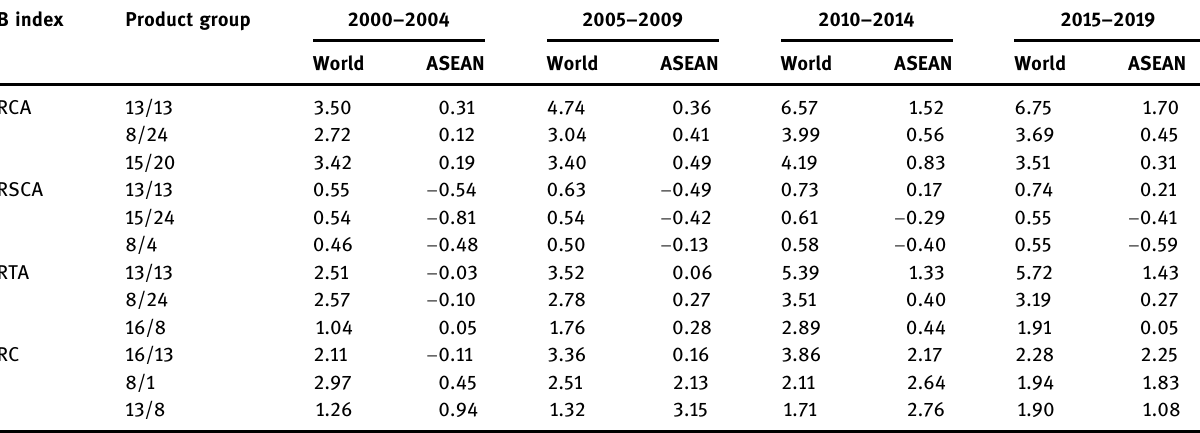
Table 10: The three highest Balassa indices of the Philippines at World and ASEAN level, 2000 – 2019